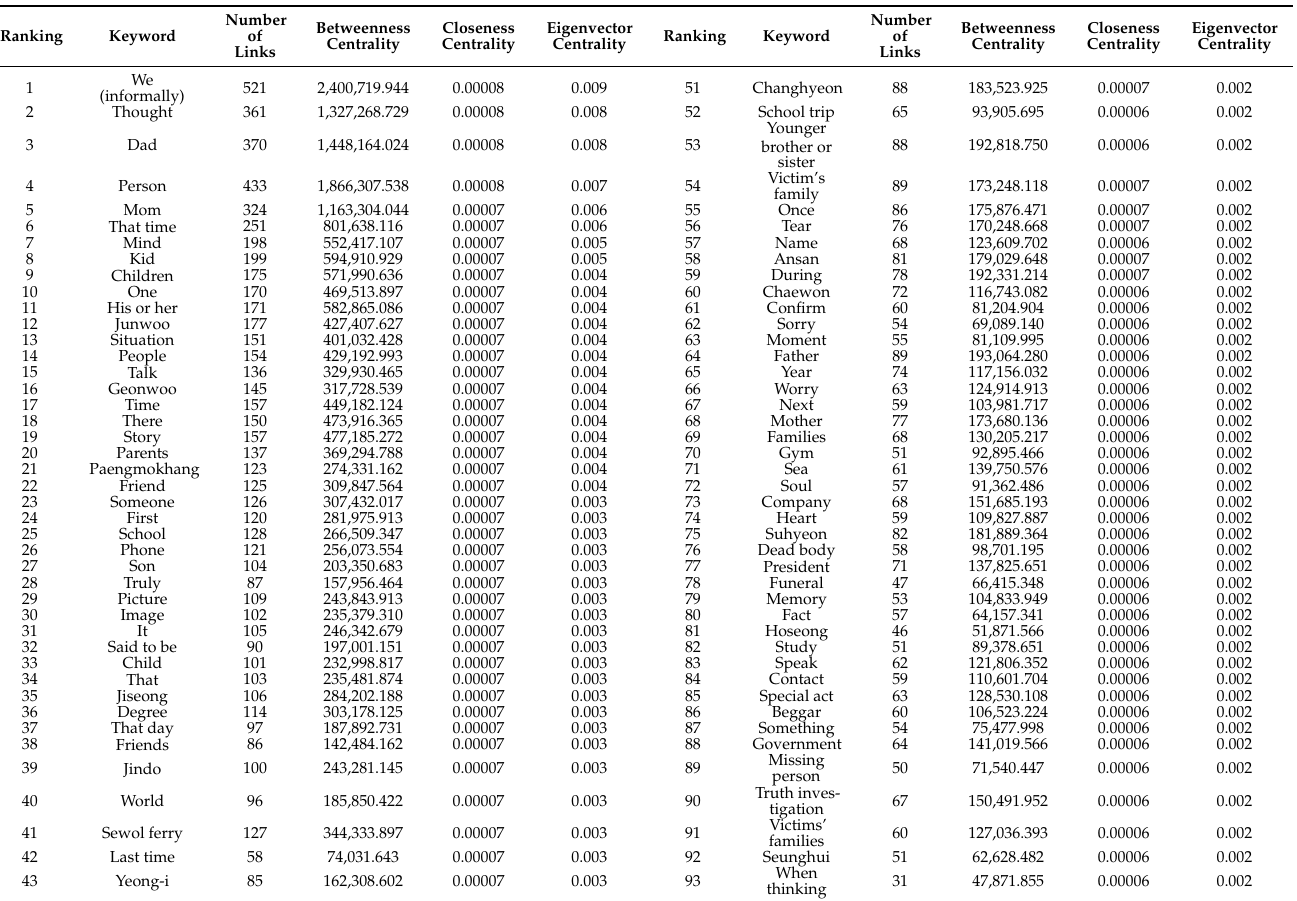
Table 5. Eigenvector centrality of victims’ family top 100